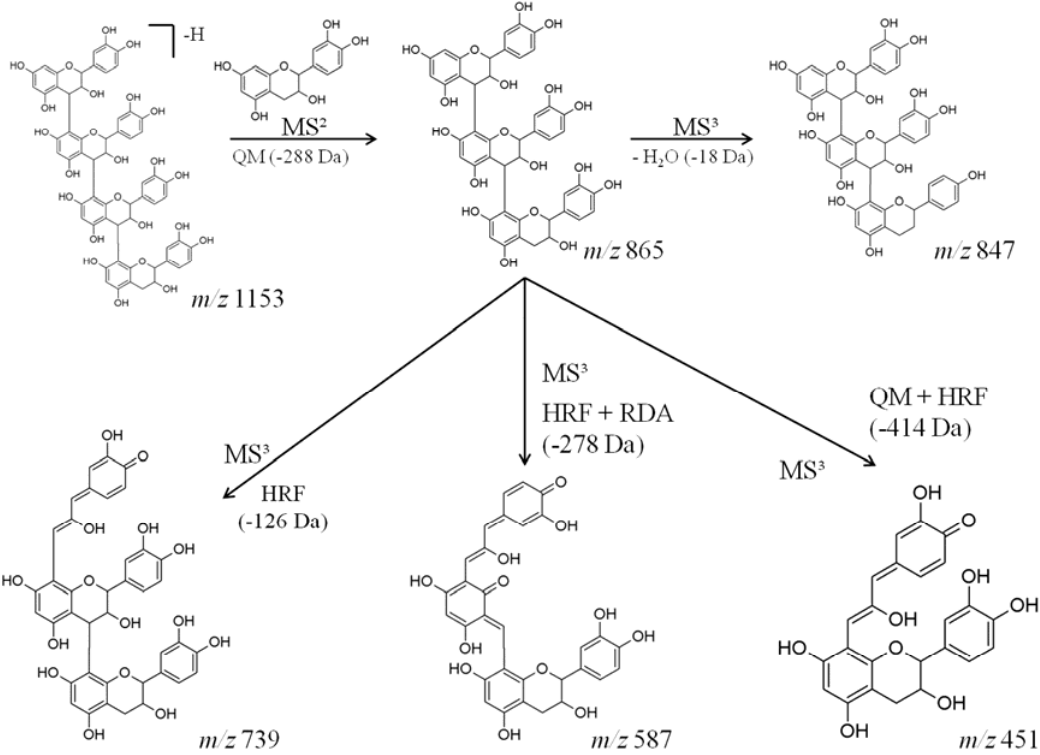
Figure 5. Fragmentation pathways of a possible tetramer proanthocyanidin found in AERM. The main fragmentation mechanisms involved are: HRF, RDA, and QM.